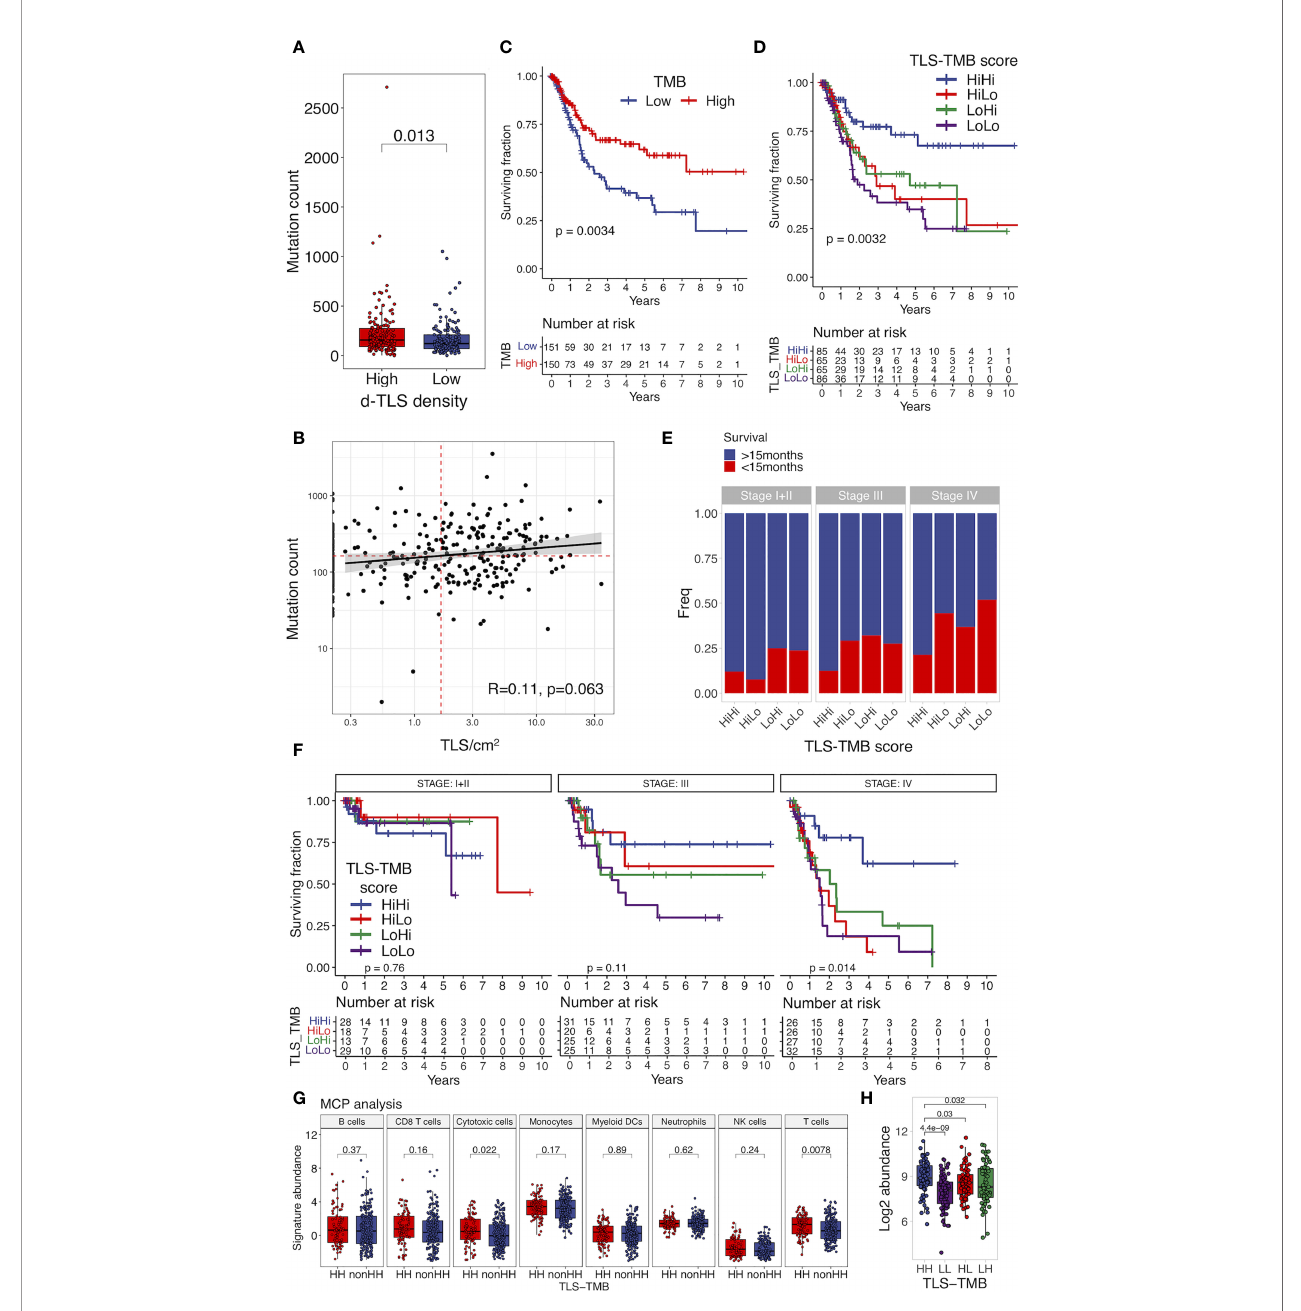
FIGURE 4 | Joint TLS-TMB score is a novel independent prognostic biomarker in MIBC. (A) Tumor mutational burden (TMB) was measured as the count of nonsynonymous mutations and was compared in patients with high and low d-TLS densities by two-tailed t -test. (B) Direct correlation between TMB and d-TLS density was analyzed by Spearman correlation. Red dotted lines represent cohort medians of the TMB and TLS density, respectively. (C) Patients with high and low TMB were de fi ned by the cohort median TMB. Overall survival was compared in TMB-high and TMB-low patients by Kaplan – Meier curve and log-rank test. (D) MIBC patients were split into four groups based on their high or low d-TLS density in combination with high or low TMB creating a joint TLS-TMB score. Overall survival was compared in the four patient groups by Kaplan – Meier curve and log-rank test. (E) Patients were strati fi ed into short-term and long-term survivors by using 15-month survival as cutoff. The proportion of patients with short- and long-term survival in the different TLS-TMB groups was compared in the context of tumor stage. (F) Overall survival of different TLS-TMB groups was analyzed in each MIBC stage separately by Kaplan – Meier curve and log-rank test. (G) Log2 abundance of cell population gene signatures was determined using the R package MCP counter and compared between TLS-TMB high – high (HH) and other (nonHH) patients by two-tailed t -test. (H) Gene expression measured by bulk tumor RNA sequencing was compared between TLS-TMB high – high and all other patients by two-tailed t -test with Benjamini – Hochberg adjustment for multiple testing. The expression of the only identi fi ed protein-coding DEG, SH2D2A, was compared for the TLS-TMB high – high group against all other groups ’ two-tailed t -test with no adjustment for multiple